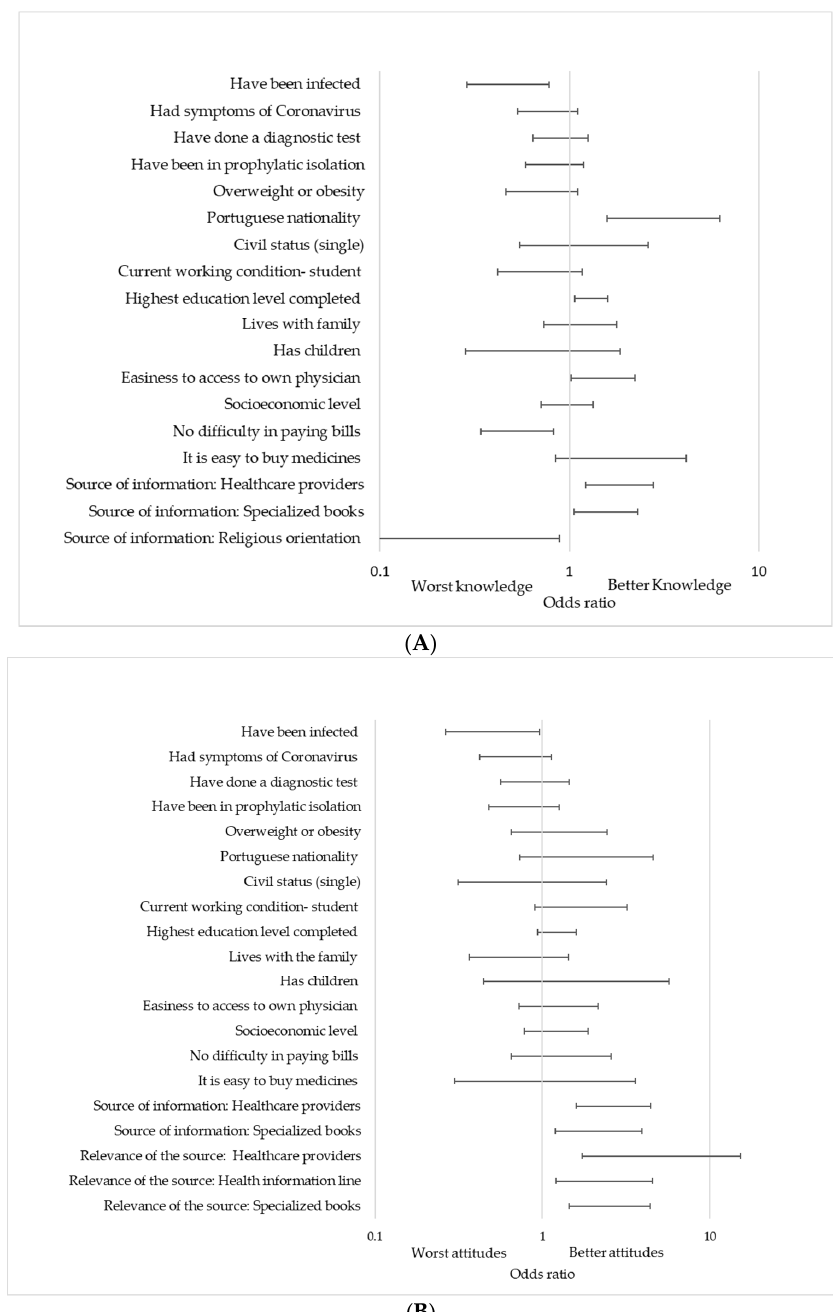
Figure 2. ( A ) Knowledge and ( B ) attitudes about